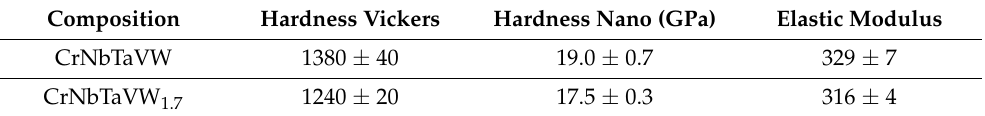
Table 4. Hardness and Elastic modulus for both compositions CrNbTaVW and CrNbTaVW 1.7 . Composition Hardness